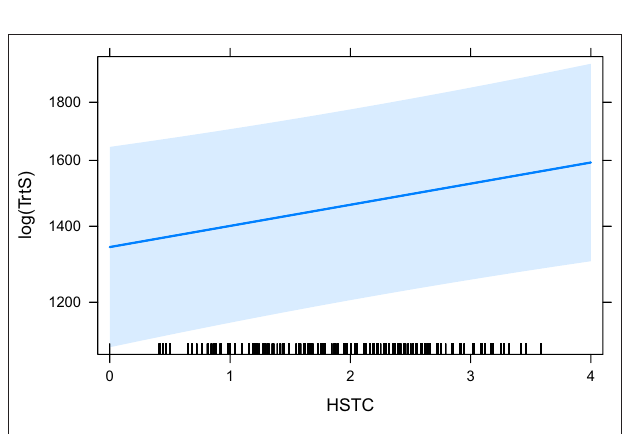
FIGURE 11 | The effect of HSTC on the logarithm of TrtS.